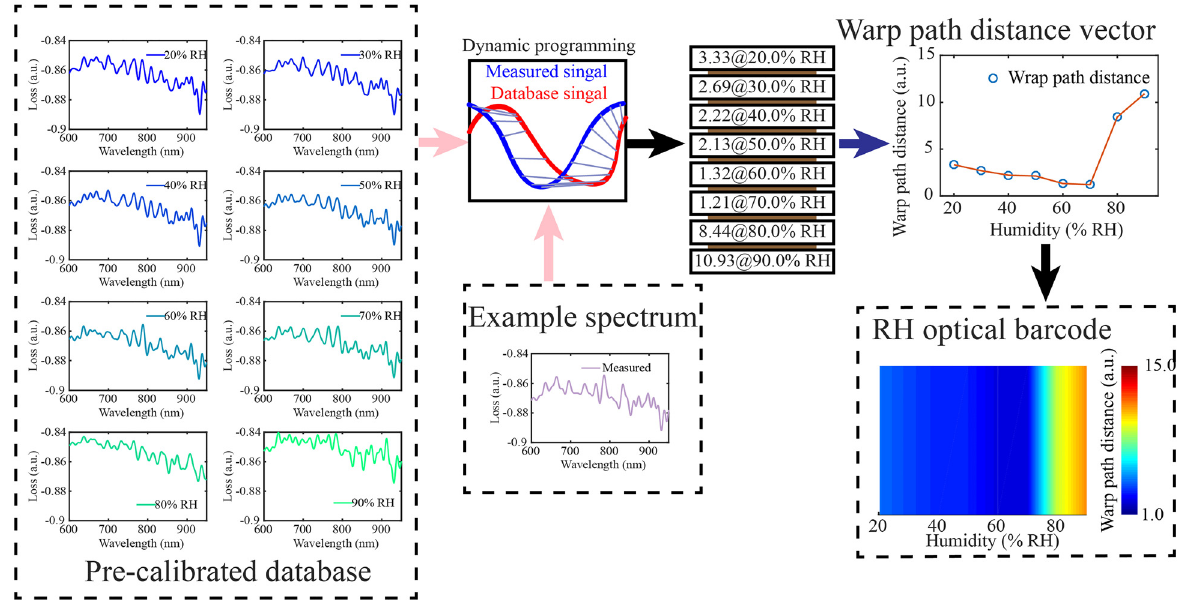
Figure 3: The process of extracting the RH optical barcode from the reflection spectrum of the RH